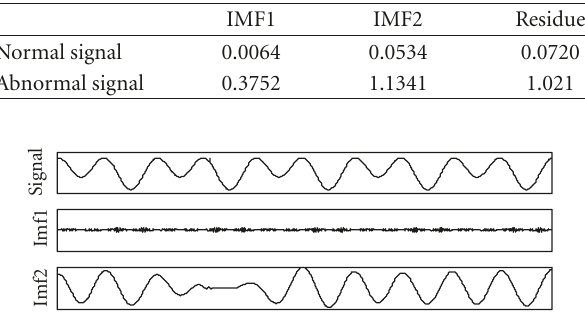
Table 1: RMSE of EMD of simulation signal.